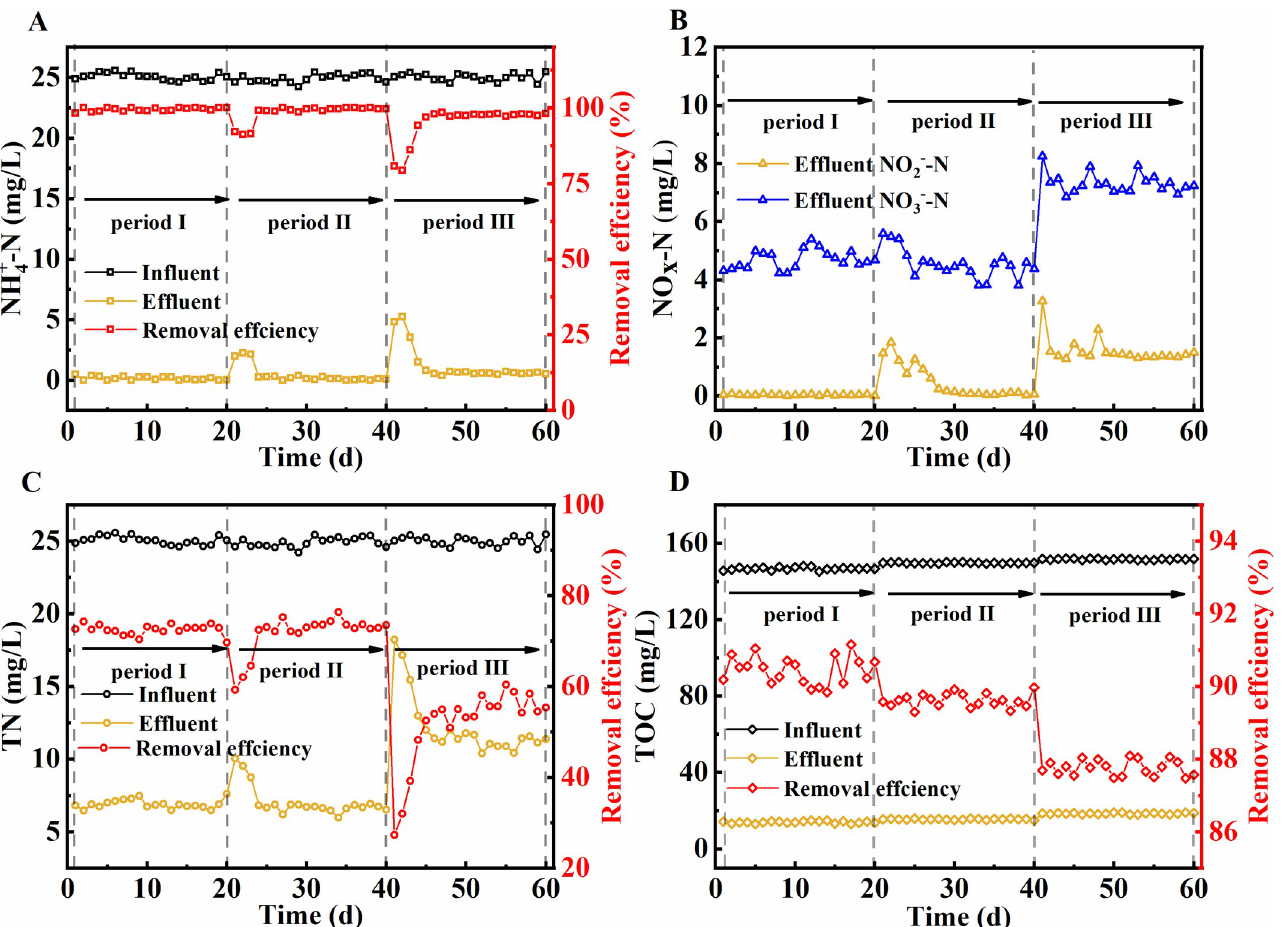
Fig 1. Concentration and removal efficiency of NH 4+ -N (A), TN (C) and TOC (D) in influent and effluent and NOx-N in effluent of MBBR(B). https://doi.org/10.1371/journal.pone.0261306.g001 maintained at 0–10 mg/L. The TOC removal rate was not affected by TC concentrations below 10 mg/L.